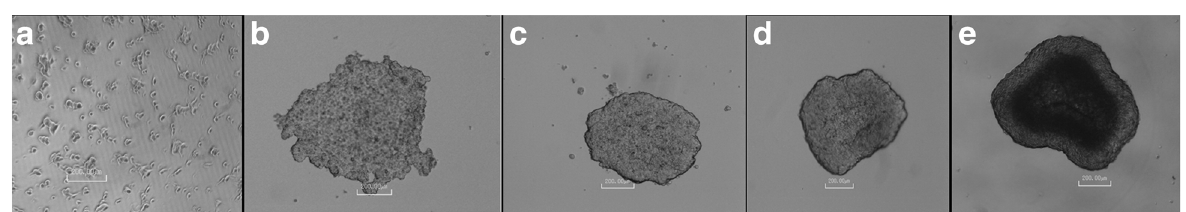
Fig. 1 Time course for LNCaP spheroid formation from seeding ( a ) and at 24 h ( b ), 48 h ( c ), 72 h ( d ), and at 168 h ( e ). Final spheroid diameter of about 600 μ m